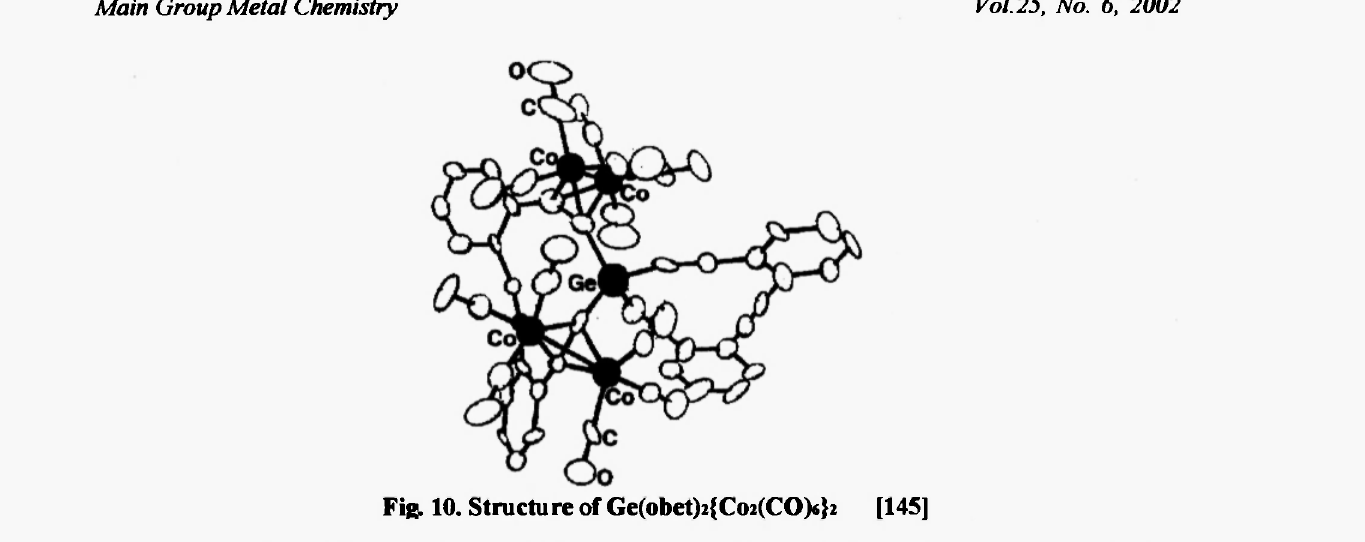
Fig. 10. Structu re of Ge(obetMCo2(COM* [145]